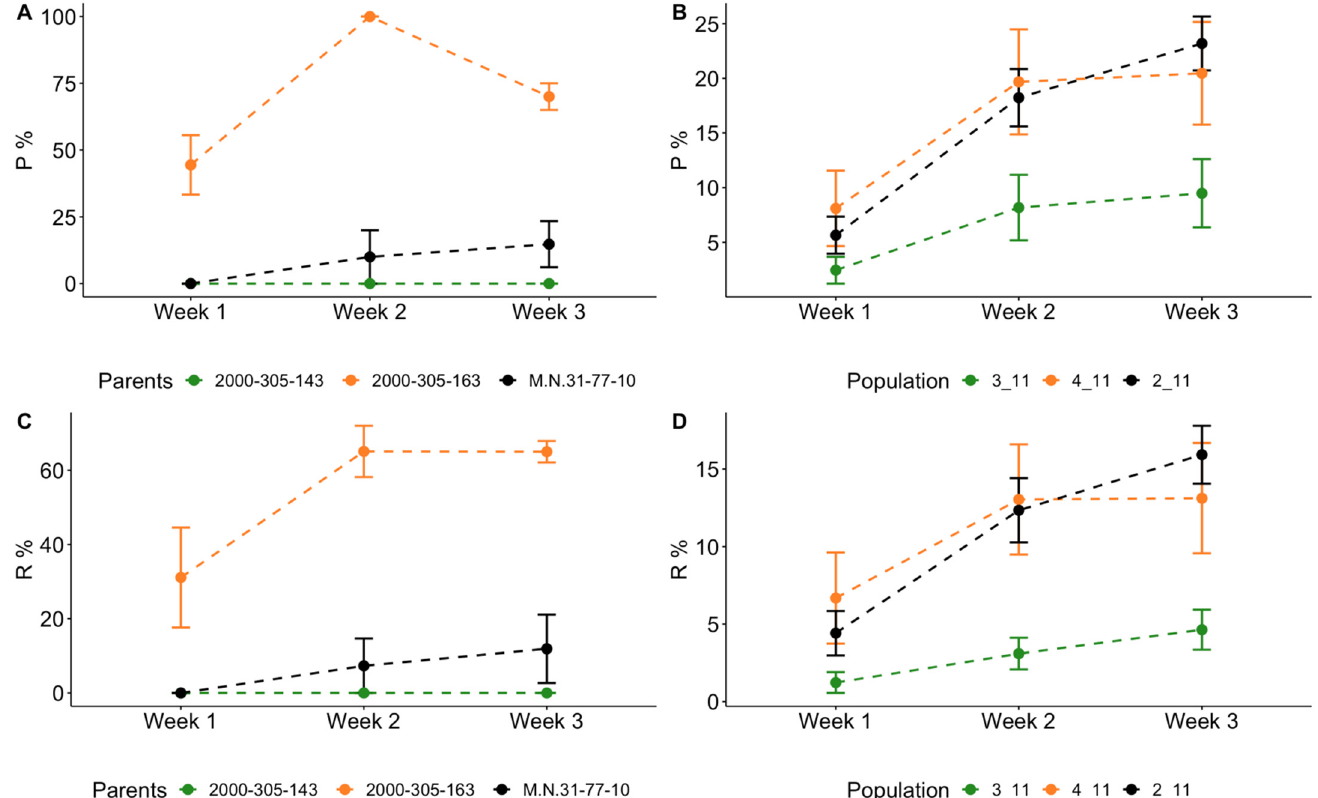
Figure 1. Assessment of resistance to the leaf form of phylloxera among populations of grape hybrids carrying M. rotundifolia introgressions in a laboratory experiment. Percentage of infested leaves (P, %) scored in first, second, third week after infection by phylloxera eggs: ( A ) among the parental lines; ( B ) among the populations of their progenies. Similarly, ( C , D ) for the intensity of gall formation (R, %).